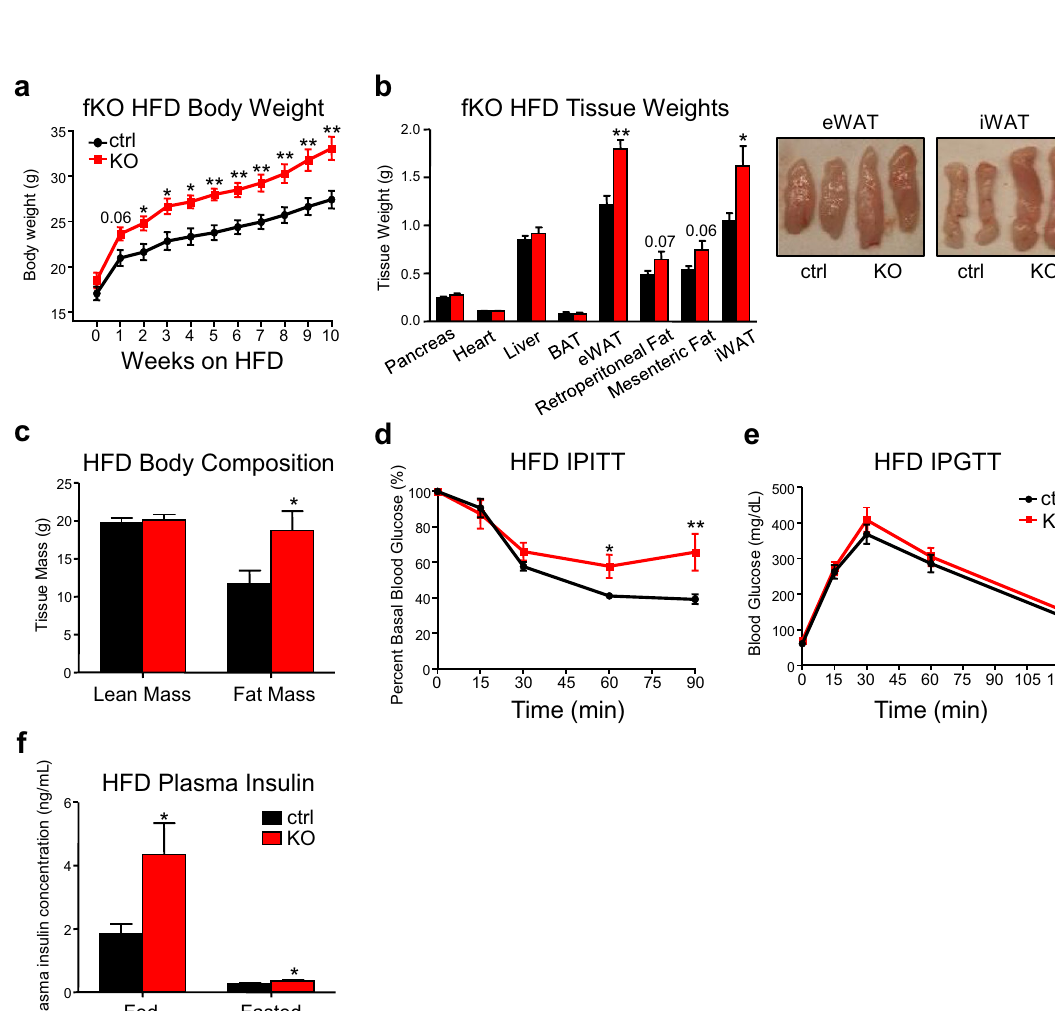
Figure 2. Fat-specific ablation of CREB3L3 enhances diet-induced obesity and insulin resistance. ( a ) Weekly body weight measurements of CREB3L3 floxed controls (ctrl) and fat-specific knockout (fKO) mice during 10 wks of high-fat diet feeding (n = 4–6 mice per group). ( b ) Tissue weight measurements for control and fKO mice after high-fat feeding (n = 4–6 mice per group). ( c ) Body composition following high-fat feeding measured by NMR (n = 6–10 mice per group). ( d , e ) Intraperitoneal ( d ) insulin and ( e ) glucose tolerance tests performed with high fat-fed control and fKO mice (n = 6–8 mice per group). ( f ) Fed and fasted plasma insulin concentrations measured with ELISA (n = 12–17 mice per fed group; 8 mice per fasted group). Data presented as mean ± SEM with sample sizes listed above. The difference in means was analyzed using Student’s t-test where *P < 0.05 and **P <